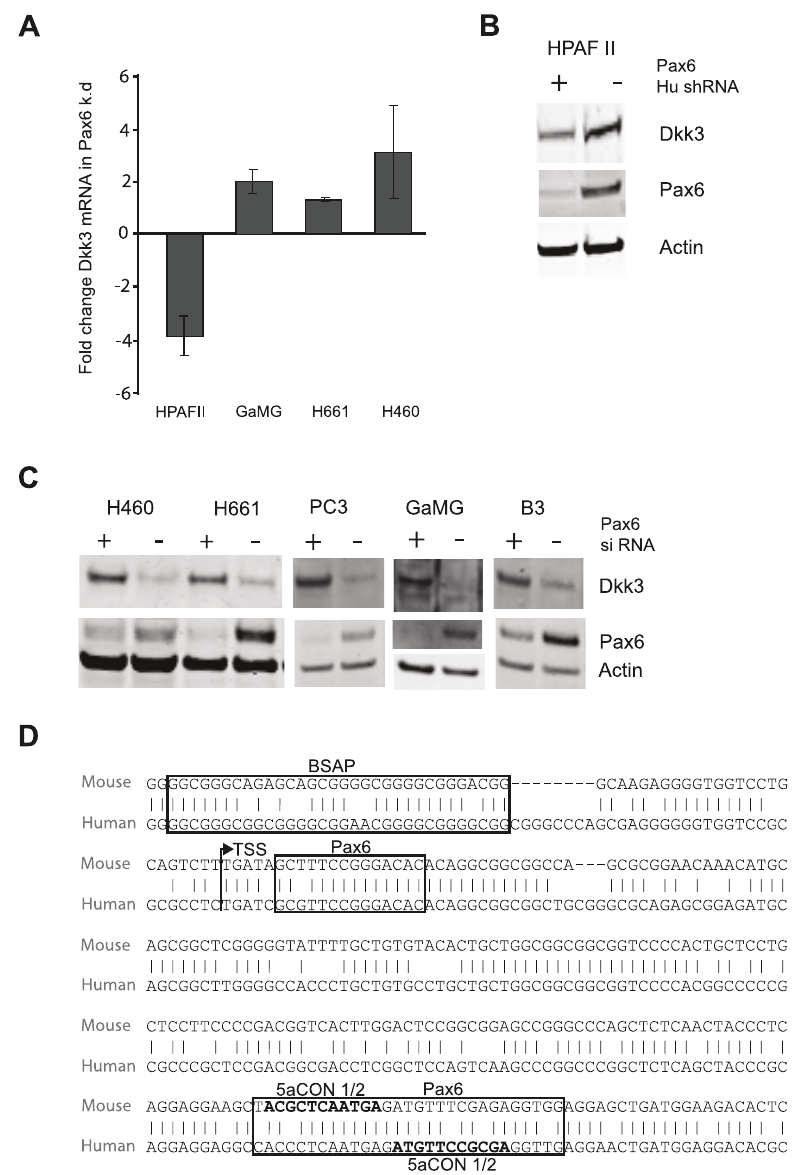
Figure 2. PAX6 regulates the expression of Dkk3 in several human cell lines derived from both normal and tumor tissues. A, RT-qPCR of human cell lines where PAX6 has been knocked down either stably by shRNA (HPAFII), or transiently by siRNA (H460, H661 and GaMG). The result is the mean of 3 independent experiments. B, Western blot of the pancreatic adenocarcinoma cell line HPAFII stably transfected with Pax6 shRNA. C, Western blot of H460 and H661 (lung cancer), PC3 (prostate cancer), GaMG (glioblastoma) and B3 (normal lens epithelium) cell lines with transient knockdown of PAX6 with siRNA. Each western blot in B and C is representative of at least two independent experiments. D, alignment of the human and mouse Dkk3 promoter showing the localisation of the bioinformatically predicted and evolutionary conserved BSAP (Pax5)-, Pax6- and Pax6(5a) binding sites. The start point for most transcripts in the mouse Dkk3 promoter is marked by an arrow (TSS-2). The human Dkk3/REIC promoter also contains multiple transcripts initiating in this area according to DBTSS. 5aCON K is a Pax6(5a) consensus halfsite with 2